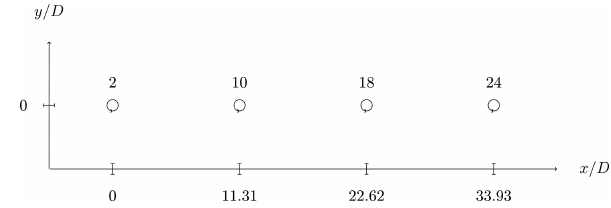
Figure 6. Four turbines in a row. The distance from turbine to tur- bine is 11.31 D (diameters). Flow is from left to right.